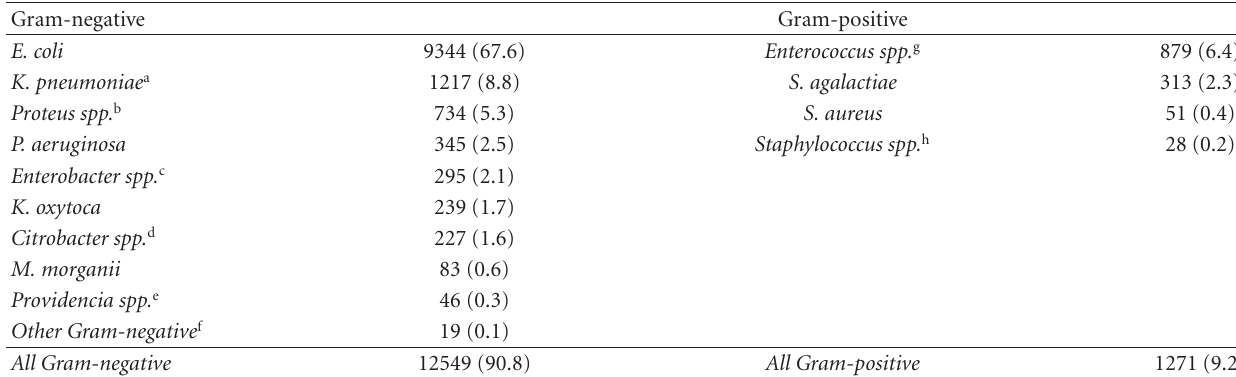
Table 1: Distribution of bacterial isolates from urine samples ( n = 13820). Data are reported as number of isolates and percentages (within brackets) of